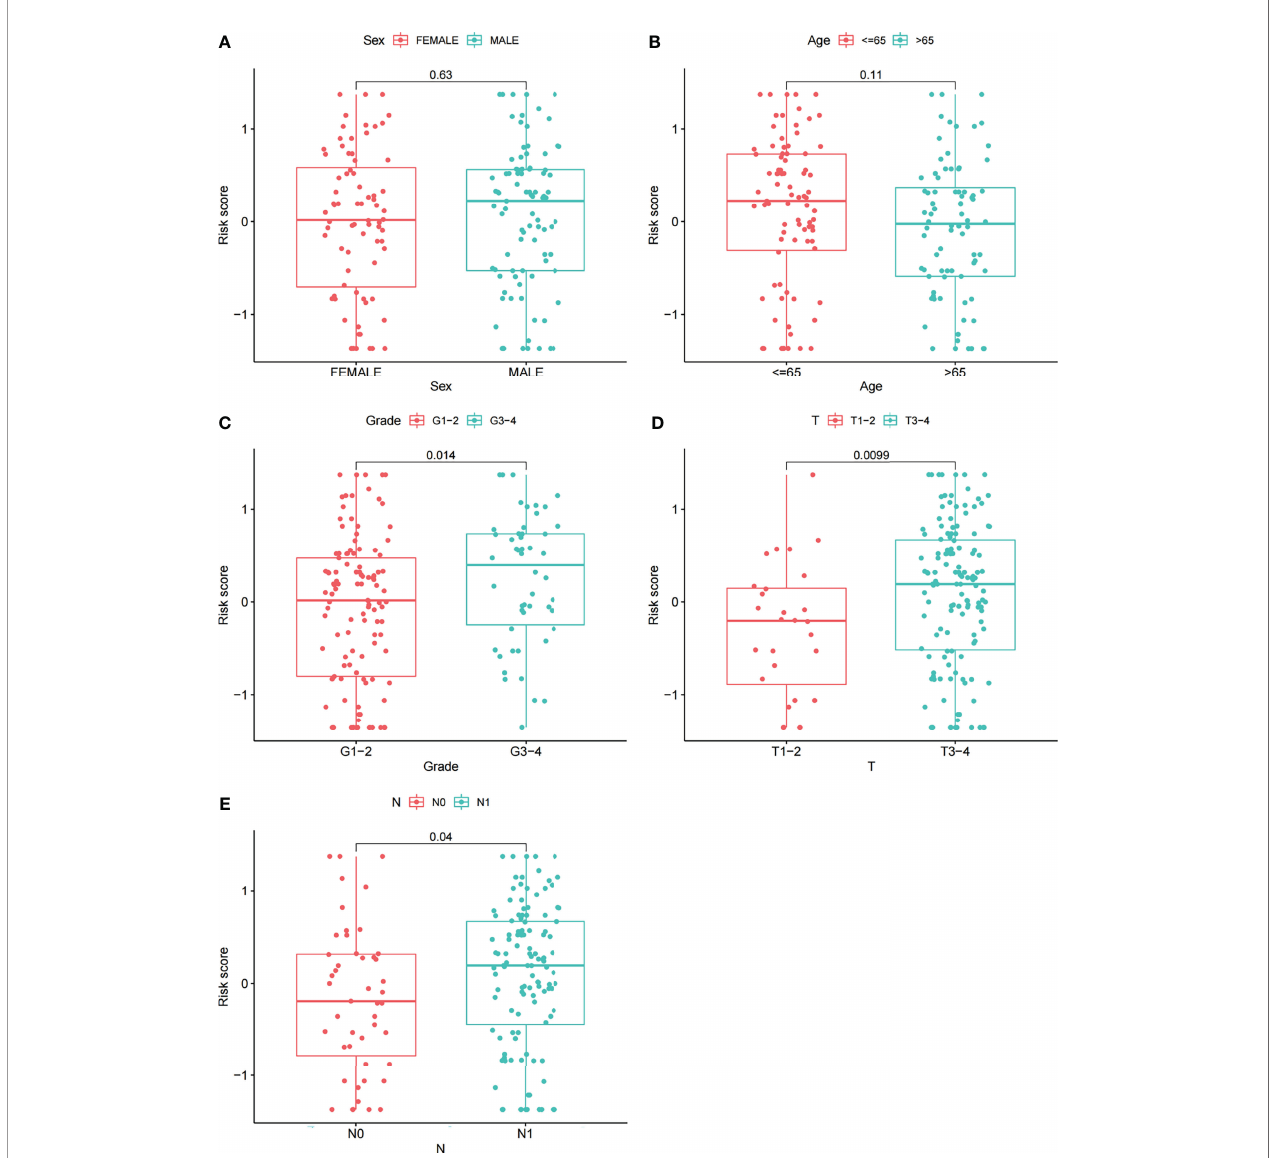
FIGURE 6 | Correlations between risk scores and clinical features. The distribution of risk scores between the two groups was examined by sex (A) , age (B) , grade (C) , T stage (D) and N stage (E)